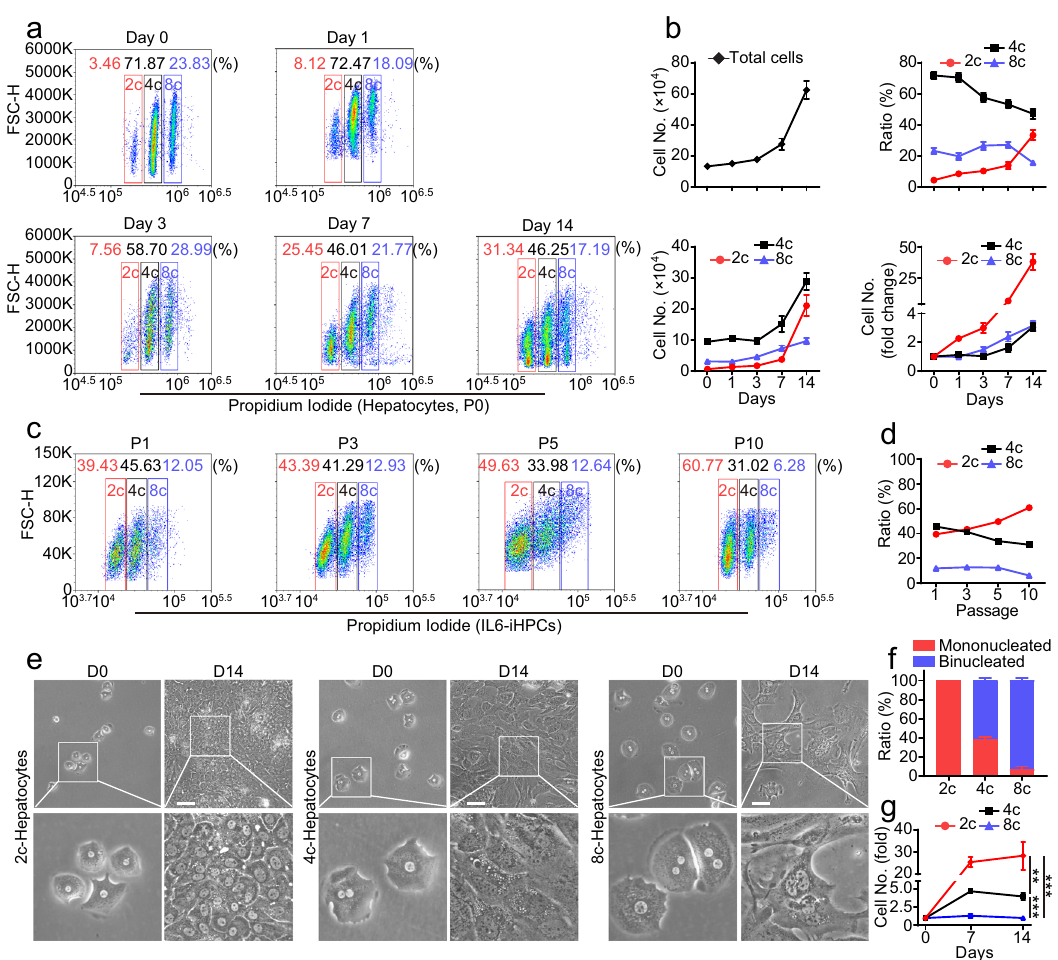
Fig. 5 | Diploid cells account for the main expansion population of IL6-iHPCs. a FACS analysis of ploidy in hepatocytes (P0) cultured in IL6-HCM at day 0, 1, 3, 7 and14. b Statisticaldataofthetotalcellnumber,theratioof2c,4cand8ccells,the number of 2c, 4c and 8c cells, and fold change of 2c, 4c and 8c cell numbers in a . DataareMeans±SEM( n =7independentexperiments). c FACSanalysisofploidyin IL6-iHPCsatpassage1,3,5and10. d Statisticaldataofthepercentagesof2c,4cand 8c cells in c . Data are Means±SEM ( n =3 independent